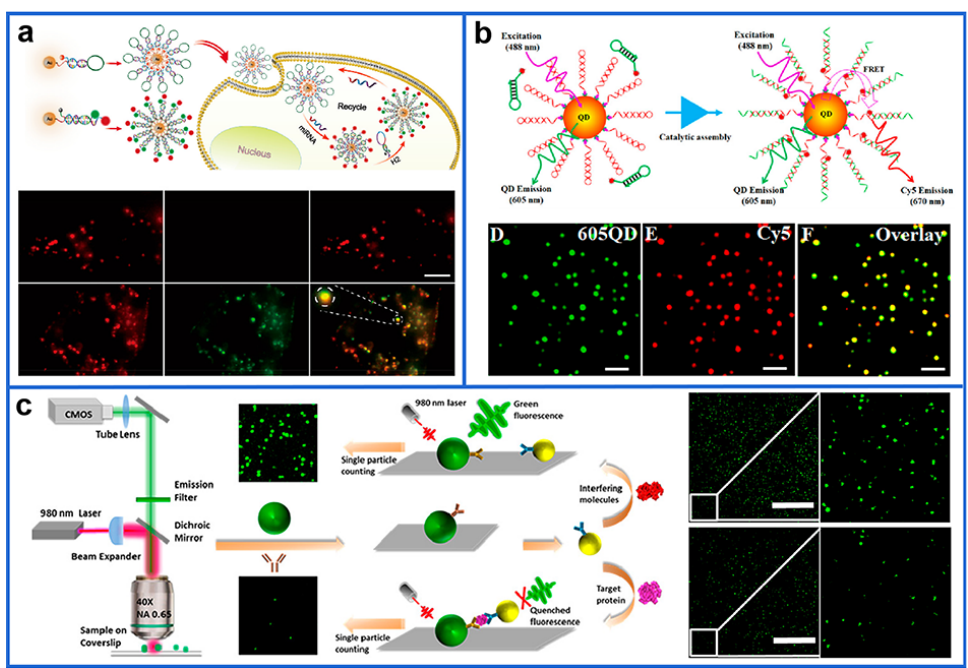
Figure 1. ( a ) Schematic of miRNA detection by the dual-color fluorescence imaging. ( b ) Principle of the catalytic assembly of the QD nanosensor directed by toehold-mediated strand displacement cascade. ( c ) Schematic diagram of the light path for the optical microscopic imaging of UCNPs and the principle of digital immunosorbent assay by single-particle enumeration. Reprinted with permission from [84,95,103]. Copyright 2020, 2019, and 2018, American Chemical Society.